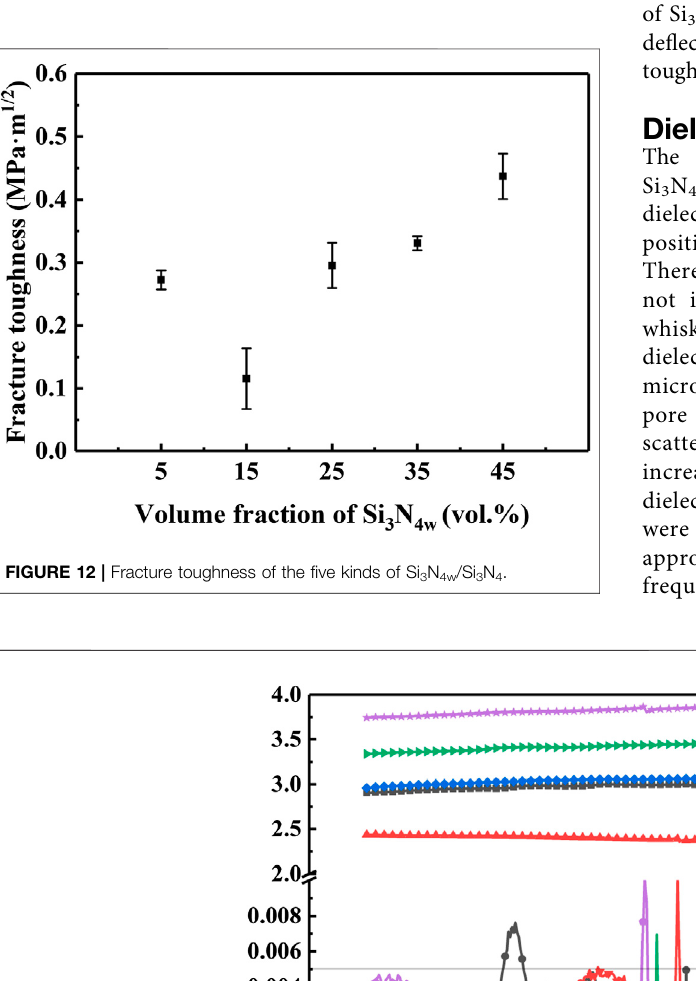
Frontiers in Materials |